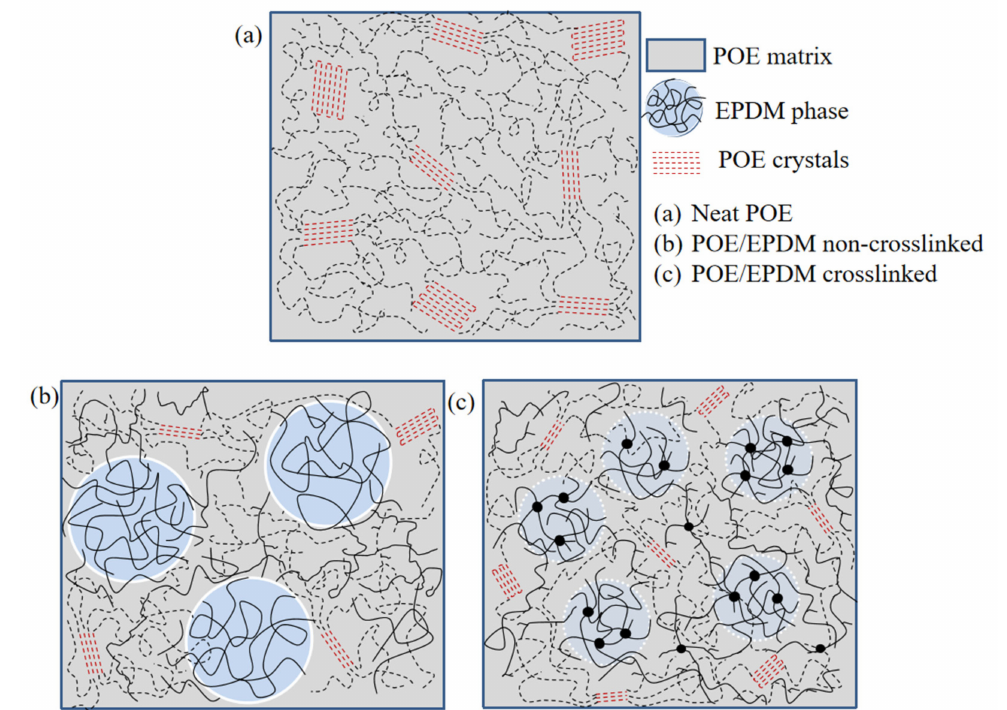
Figure 4. Structural depiction of POE and the blends. ( a ) Neat POE. It forms mixed individual crystals with folded chains and fringed micellar crystals (red dotted line). ( b ) POE/EPDM blends. Although EPDM has a certain compatibility with POE, the blend system still forms a phase-separation structure. ( c ) Dynamic crosslinked POE/EPDM blends (take POE:EPDM = 60:40 as the